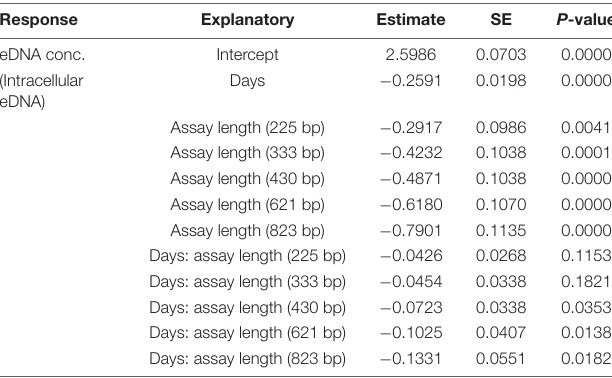
TABLE 5 | GLM analysis results for testing response of intracellular (PMA) eDNA copy numbers to days and assay length. Response Explanatory Estimate SE P -value eDNA conc.